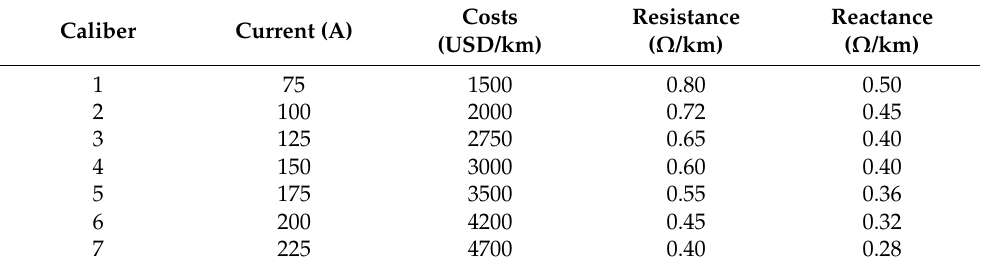
Table 2. Possible calibers for a numerical example.